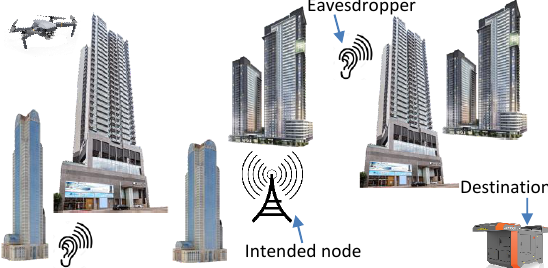
Figure 1. Illustration of the considered